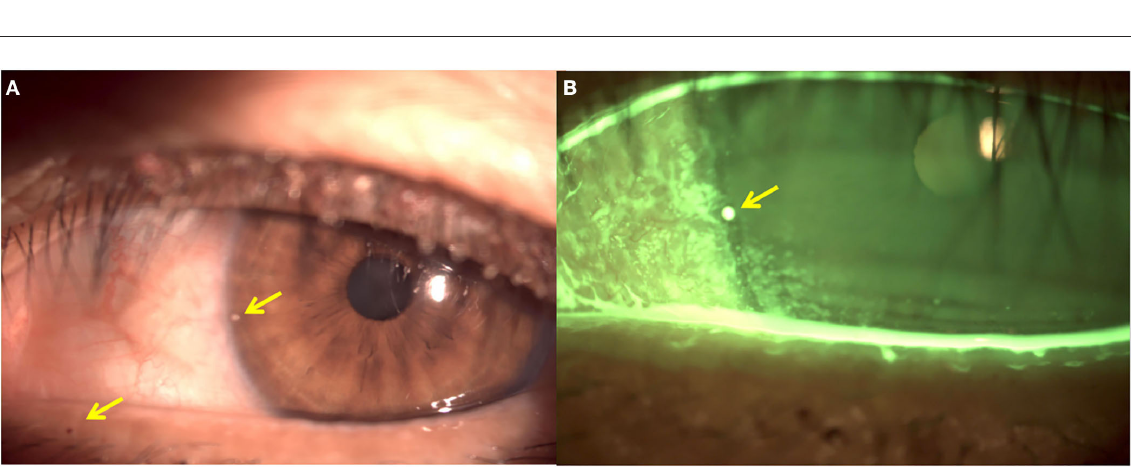
ocular discomfort and in view of the coronavirus disease 2019 (COVID-19) pandemic. Therefore, further studies are warranted to provide more